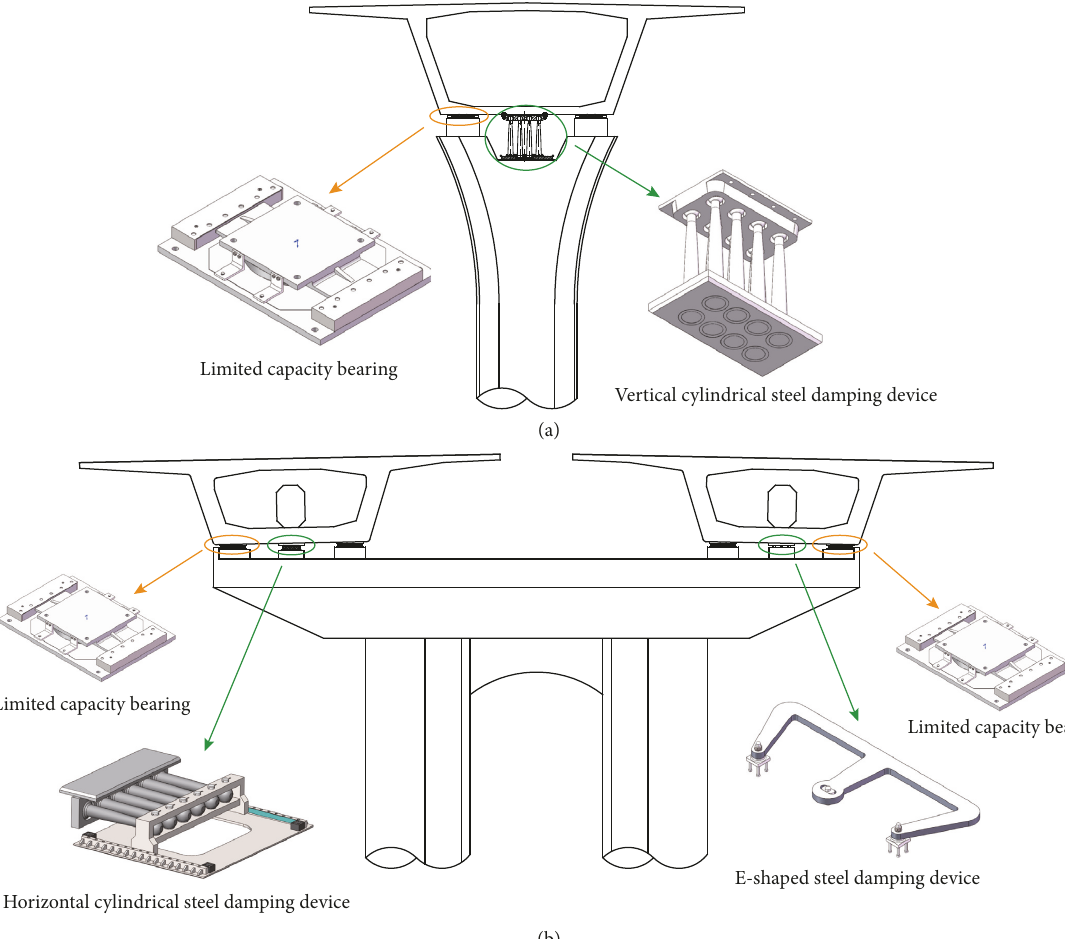
Figure 7: Combination of limited capacity bearings and different damping devices. (a) Limited capacity bearing+ vertical cylindrical damping device. (b) Limited capacity bearing+E-shaped damping device or limited capacity bearing+horizontal cylindrical damping device.